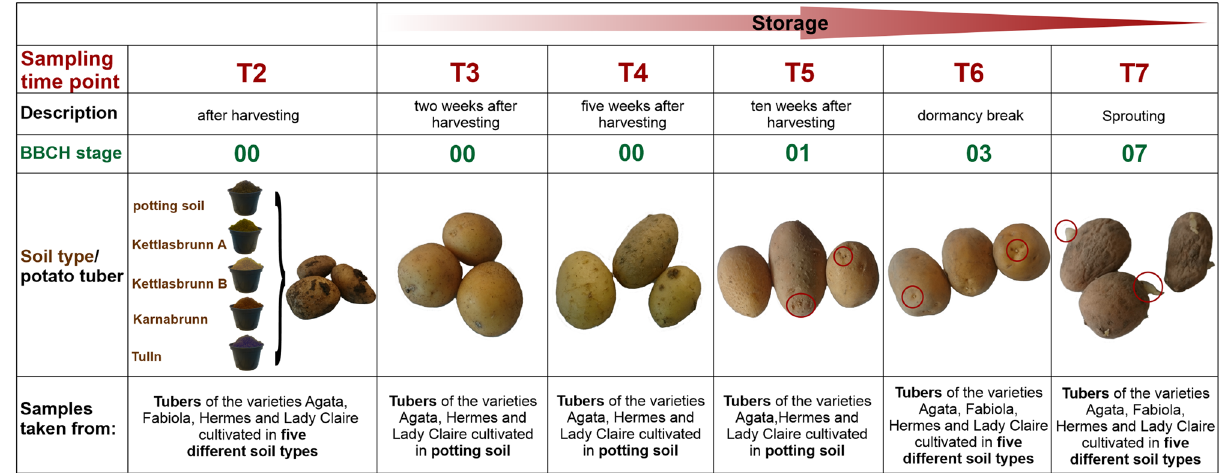
Figure 1. Overview of potato cultivars, sampling time points and corresponding BBCH stages investigated in this study. After harvesting four tuber varieties (Agata, Fabiola, Lady Claire and Hermes) from five different soil types (T2), tubers were stored at 8–10 °C in darkness. After 2 (T3), 5 (T4) and 10 weeks (T5), tubers were sampled. To consider the individual dormancy break (T6) of each variety, tubers were sampled according to the BBCH scale at stage 03. The same procedure was performed for samples that were taken at sprouting at stage 05 (T7). Additionally, at T7, sprout samples were taken. At each sampling time point, tuber/sprout samples were used for 16S rRNA gene amplicon sequencing. The red circles mark sites on the tubers that show visible signs of